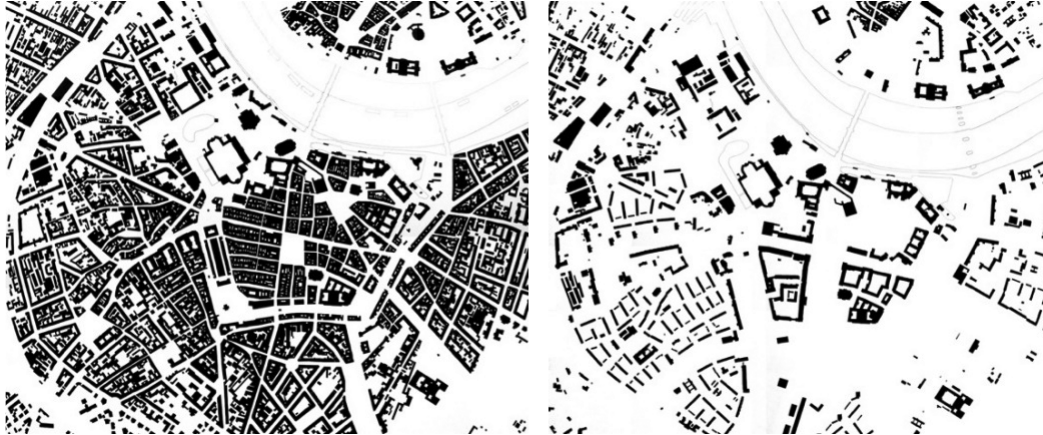
Figure 13. Before and after the war: Solid-void plan of the city center of Dresden. Source: Curdes (1993). Urban Planning, 2019, Volume 4, Issue 3, Pages